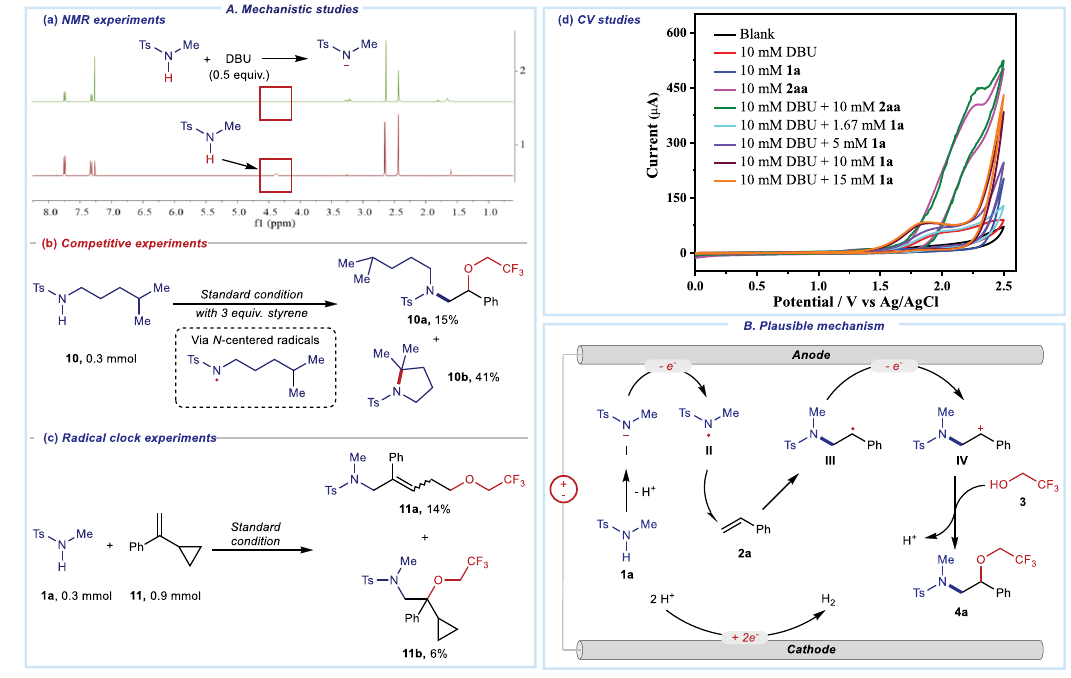
Fig. 4 | Mechanistic studies and plausible mechanism. A Mechanistic studies. a NMRexperiments. b Competitiveexperimentsbetweenintermolecular1,2-amino